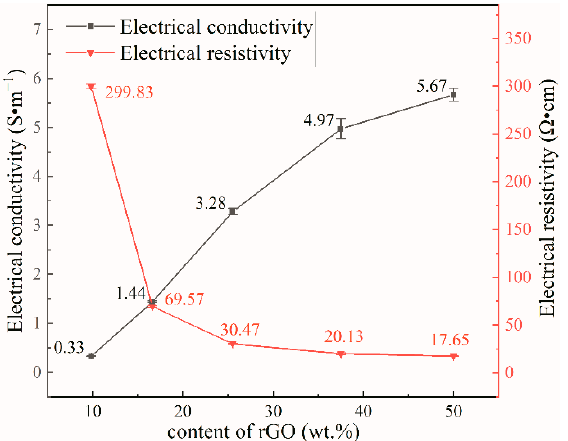
Figure 7. Electrical resistivity and conductivity of composite films with different rGO